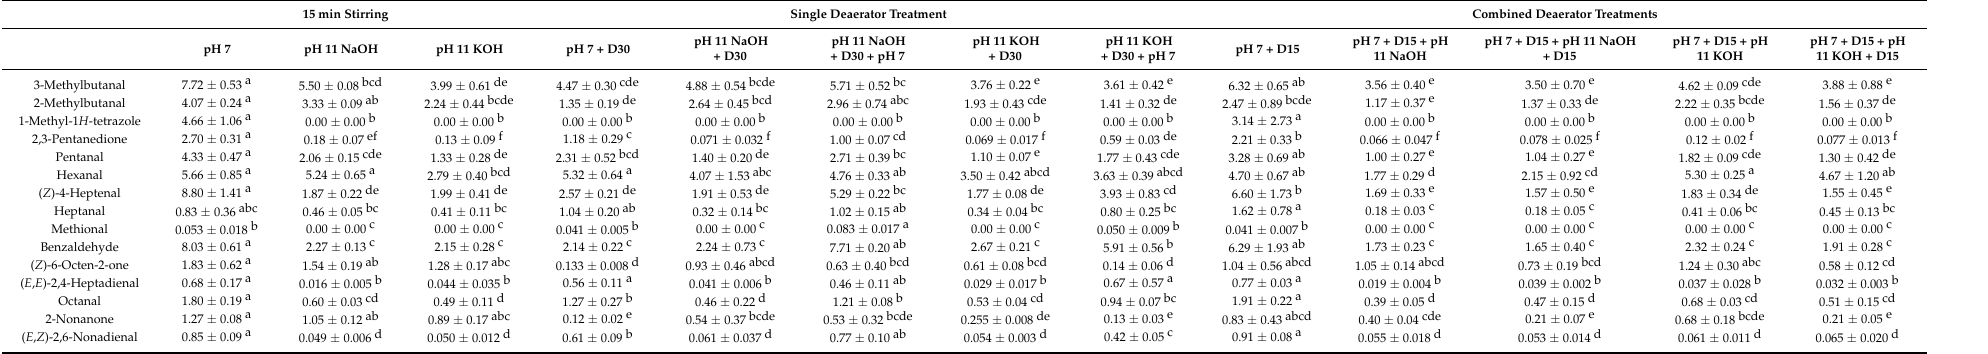
Table 2. Abundance of the most potent odor-active compounds of HMH ( × 10 7 arbitrary units (AUs)) after the 15 min stirring and after the different treatments (mean ± standard